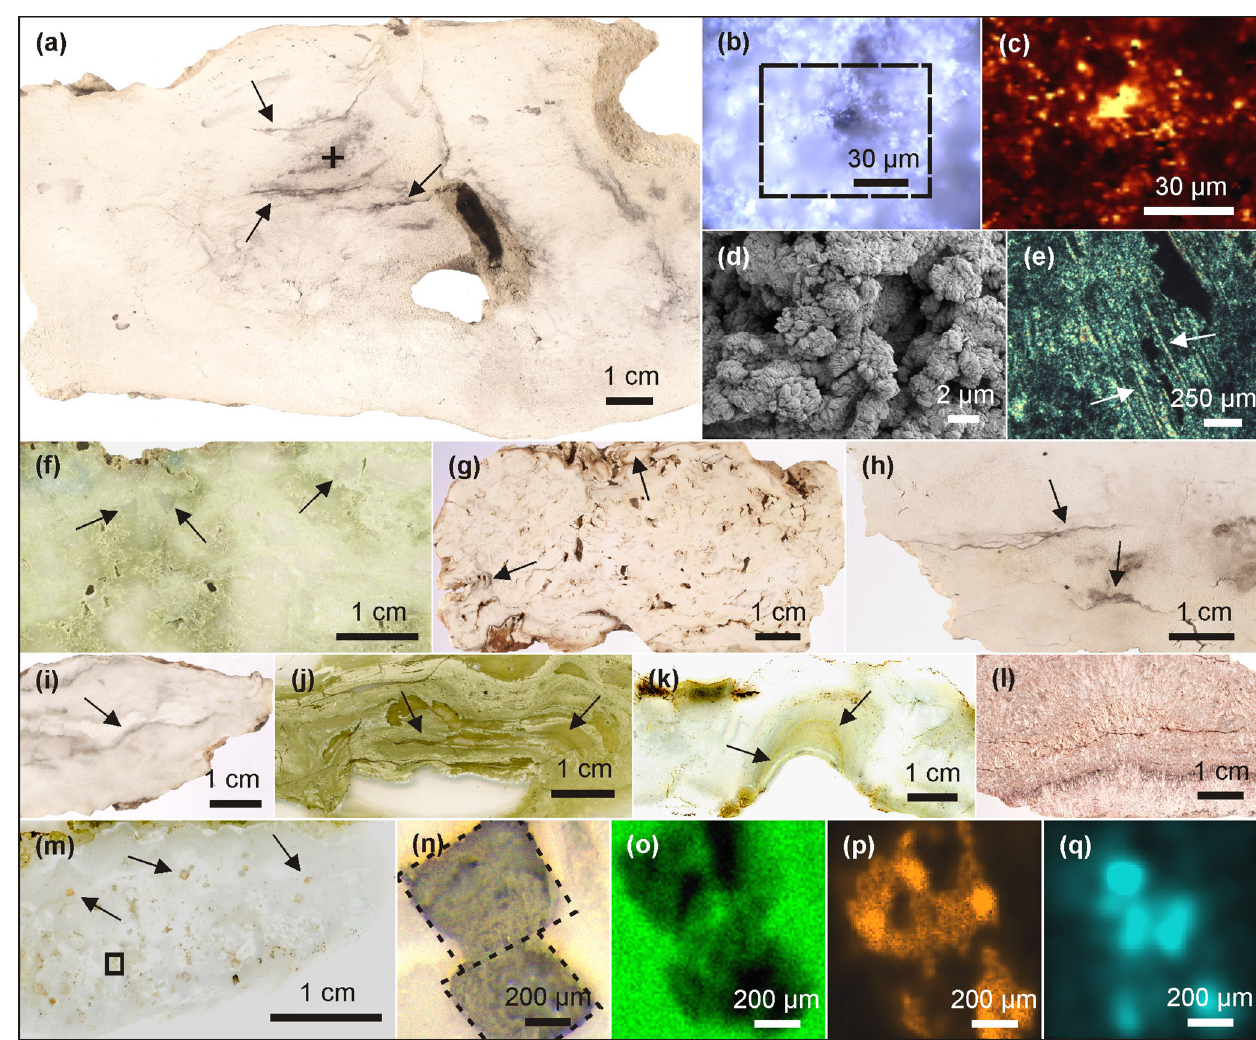
Figure 1. Petrographic characteristics of Lake Magadi cherts. (a) Polished slice of LM-1692, revealing organic matter in the silica matrix (arrows). The cross marks the spot for Raman mapping (detailed in b–c ). (b) Area of Raman mapping at − 2 . 5µm (dashed box, image scan 94 pixels × 72 pixels). (c) Raman mapping result; yellow color indicates high abundances of organic matter. (d) SEM image from LM-1692, showing a porous matrix of microcrystalline quartz. (e) Silicified bacterial filaments from LM-1699 under polarized light (see arrows). (f) Brecciated texture (arrows) in LM-1699. (g) Cloudy microbial features (arrows) in LM-1694. (h) Layered organic matter (arrow) in LM-1693. (i–k) Laminated microbial mat patterns (arrows) preserved in LM-1695 (i) , LM-1697 (j) , and LM-1698 (k) . (l) Silica sinter from the Great Geysir, Iceland (IC-1700). (m) Carbonate rhombs (arrows) enclosed in the chert matrix of LM-1696. The box marks the area for µ-XRF scanning (n–q) . (n) Close-up of boxed area showing carbonate rhombs under reflected light. (o–q) µ-XRF analyses of the same area showing silica (o) , calcium (p) , and sulfur (q) distributions (a brighter color indicates a higher concentration). Sulfur enrichments accompanied by calcium point to the presence of gypsum associated with the carbonate